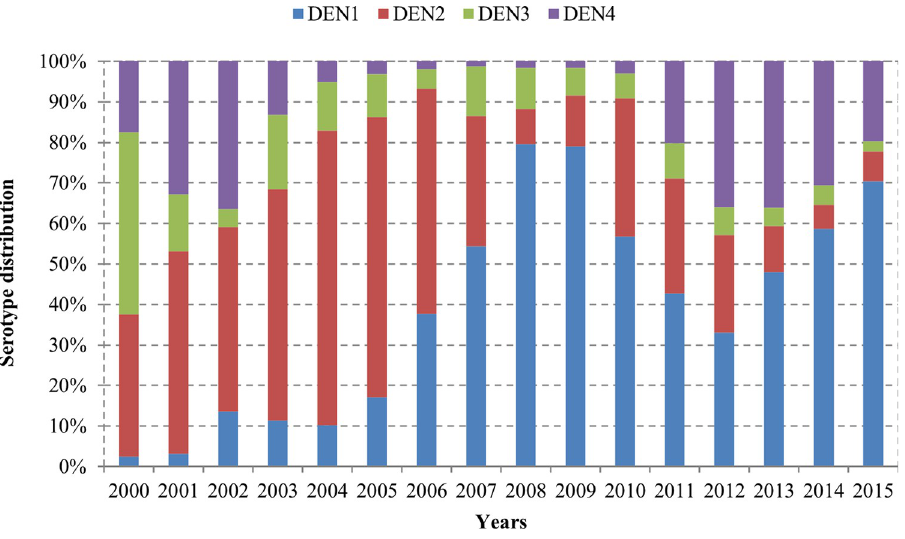
Fig 6. Annual distribution of dengue serotypes (N =